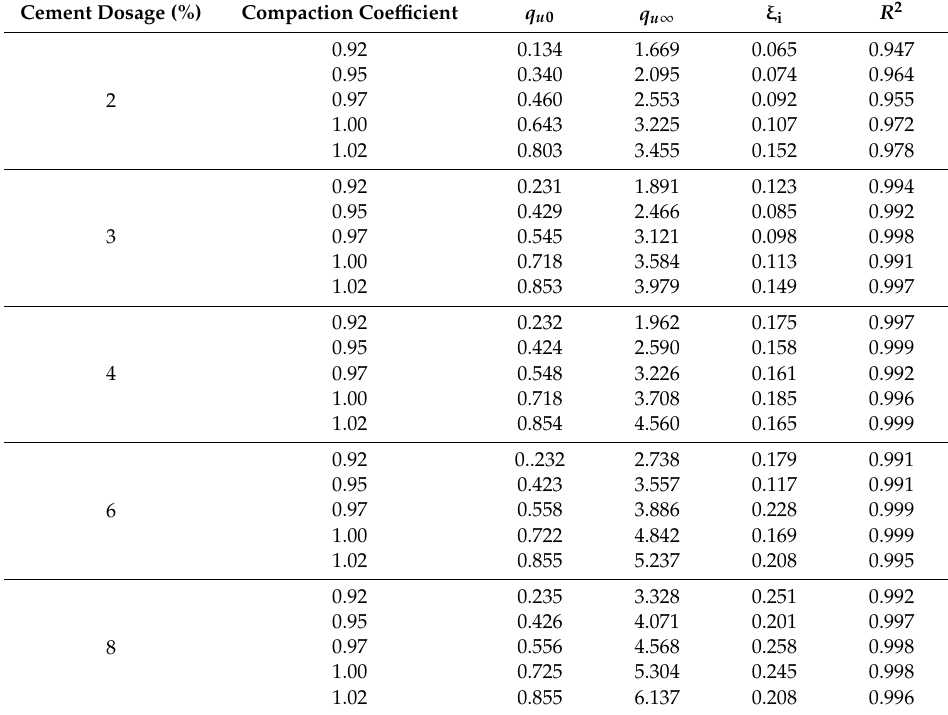
Table 4. Estimation equation for unconfined compressive strength of cement-improved loess. Cement Dosage (%)